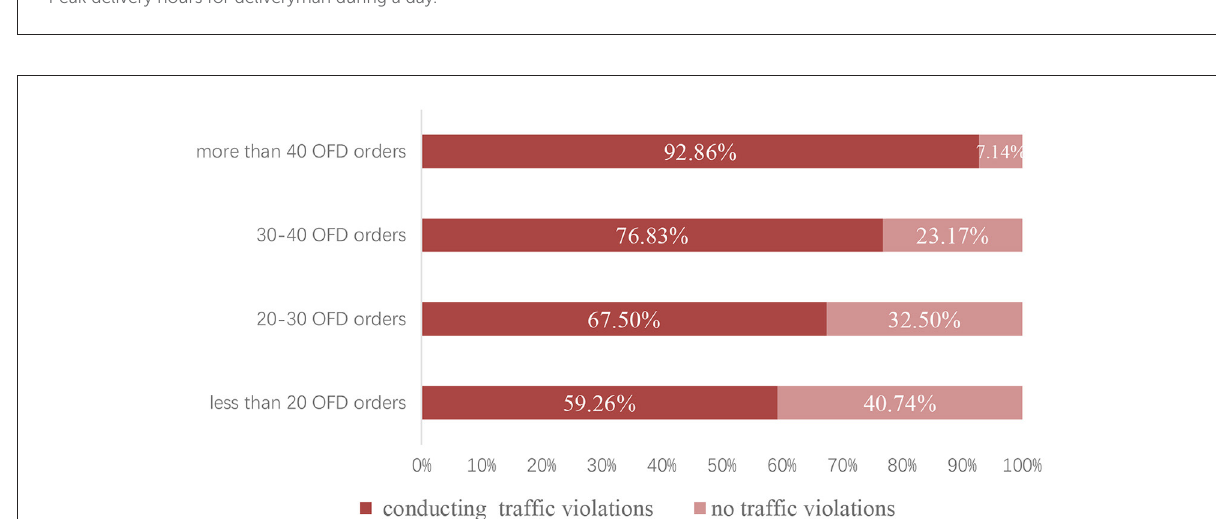
FIGURE1 Peak delivery hours for deliveryman during a day.